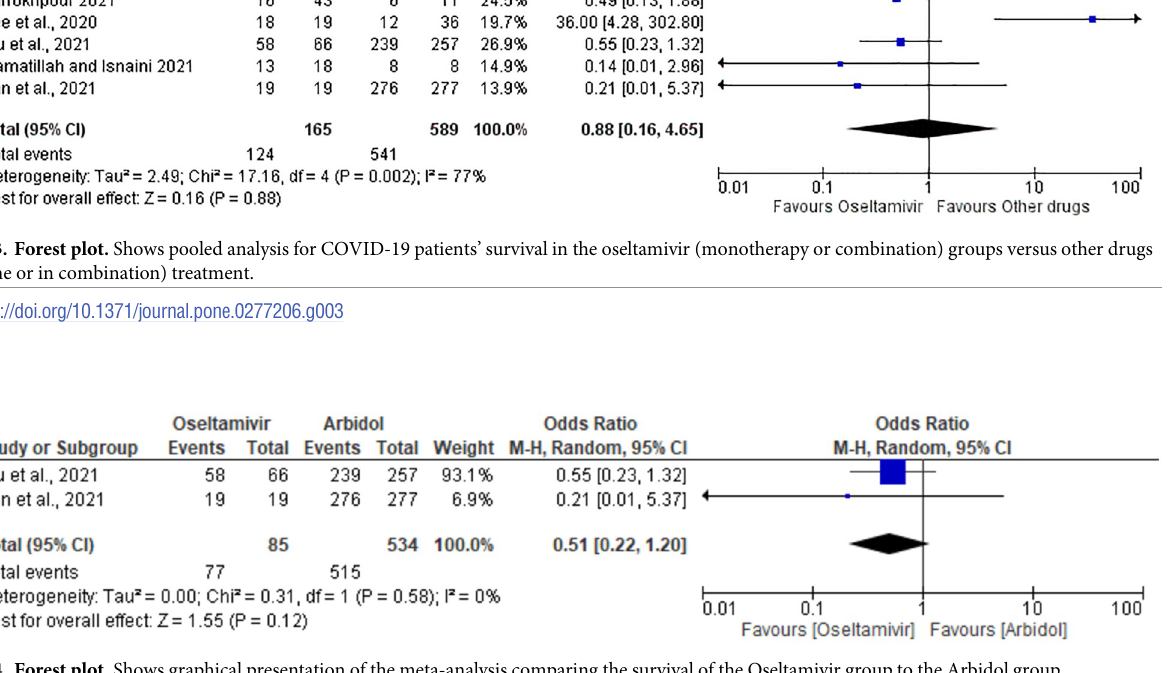
Fig 4. Forest plot. Shows graphical presentation of the meta-analysis comparing the survival of the Oseltamivir group to the Arbidol group.